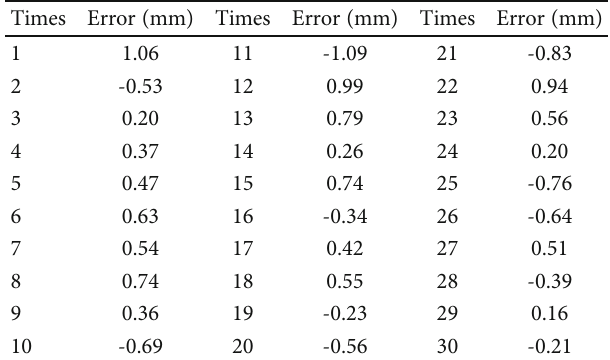
Figure 15: Line chart of error at three movement distances. Table 5: Precision and accuracy of di ff erent movement distances. Table 7: Positioning error of hydraulic rod at 8mm/s